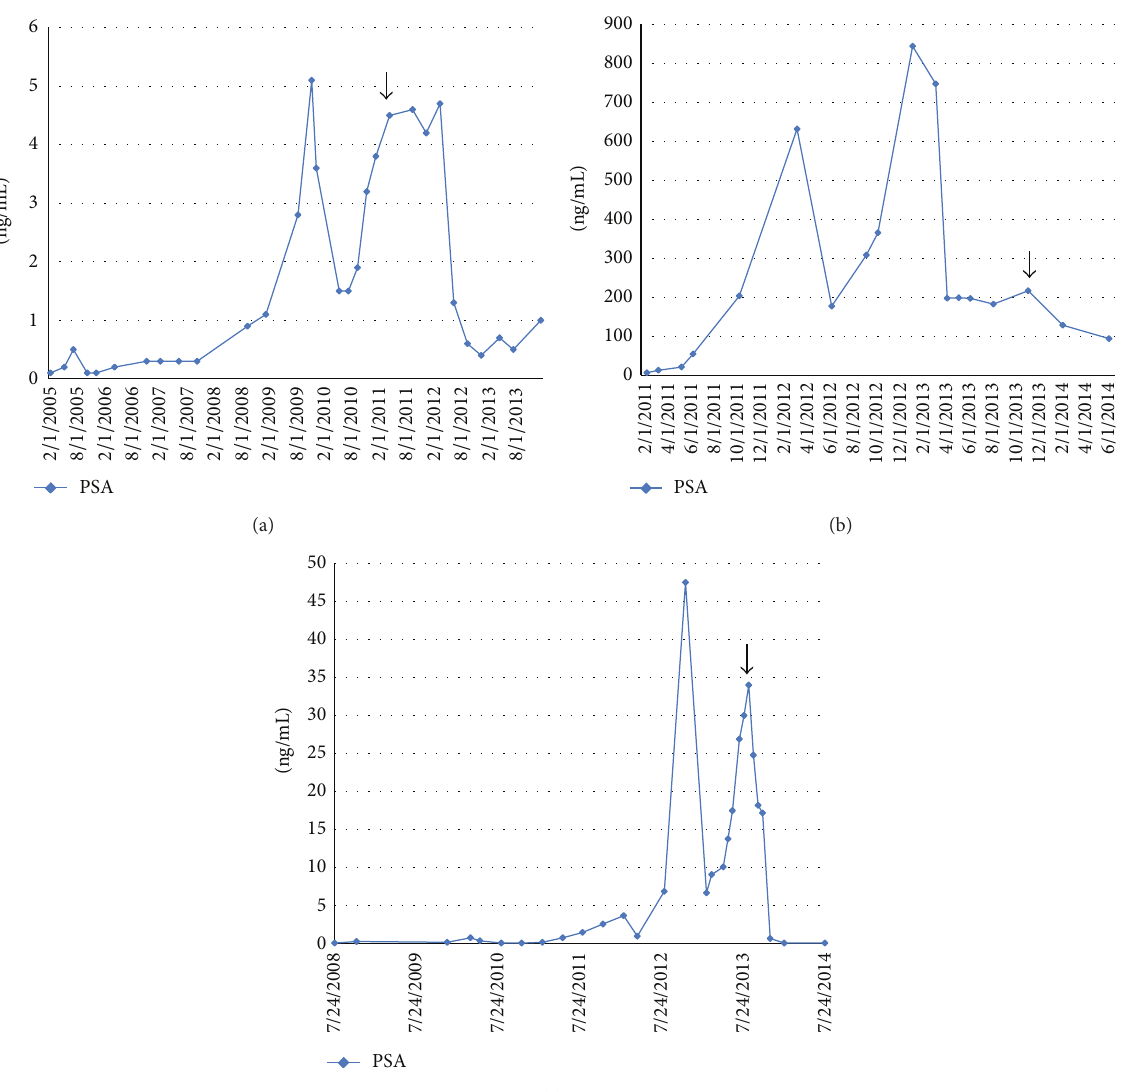
Figure 1: PSA plot for each patient and arrows indicate the initiation of combination therapy with metformin and/or Zyflamend ( 𝑥 -axis: time, 𝑦 -axis: the value of